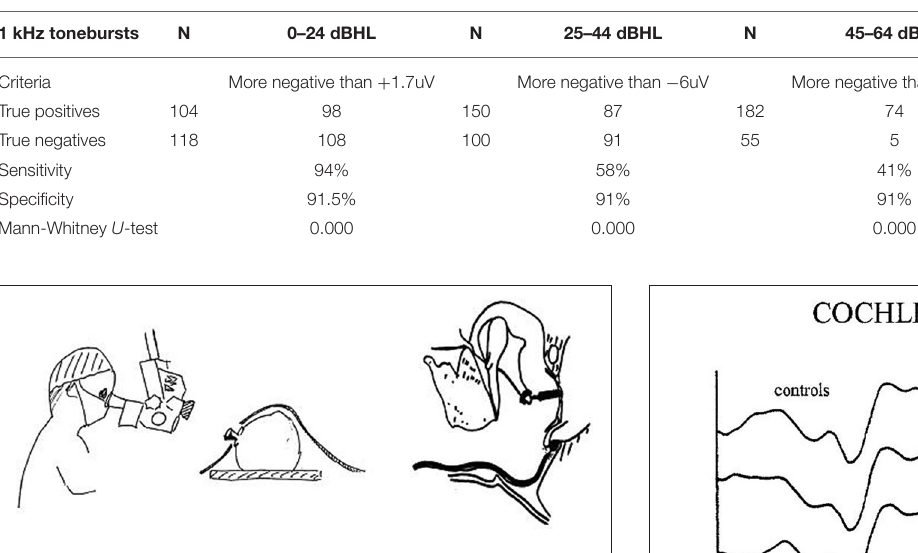
TABLE 2 | Transtympanic EcochG results for 1 kHz tone burst stimuli.